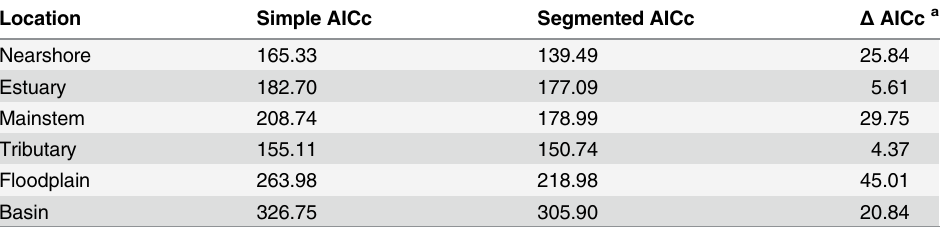
Table 3. Akaike ’ s Information Criterion for Simple and Segmented Regression Analyses: Puget Sound Scale.